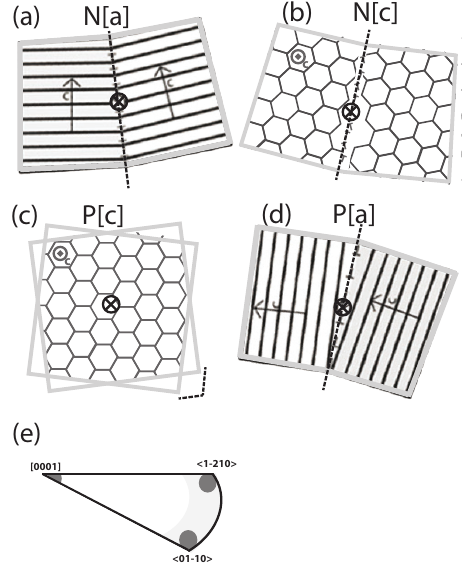
Figure 5. Schematic diagram showing some SGB types (modi- fied from Weikusat et al., 2010, 2011). Four end member types of boundaries are shown. The rotation axes, R , are marked as circles with an X inside; the parallel lines and hexagons represent the basal plane and are perpendicular to the c-axis, shown by arrows or as a grey circle with a dot inside. The dashed lines denote the SGB plane trace; in panel (c) the SGB plane is in the plane of the paper. Panels (a) and (b) show SGBs with the boundary plane perpendicular to the basal plane, which are N-type SGBs. Panels (c) and (d) show subgrain boundary planes parallel to the basal plane, which are P- type SGBs. R is perpendicular to the c-axis in (a) and (d) and is parallel to the c-axis in (b) and (c) . (e) A simplified inverse pole fig- ure of the rotation axes parallel and perpendicular to the c-axis (dark grey circles). Possible slip systems for these SGB configurations are described in the